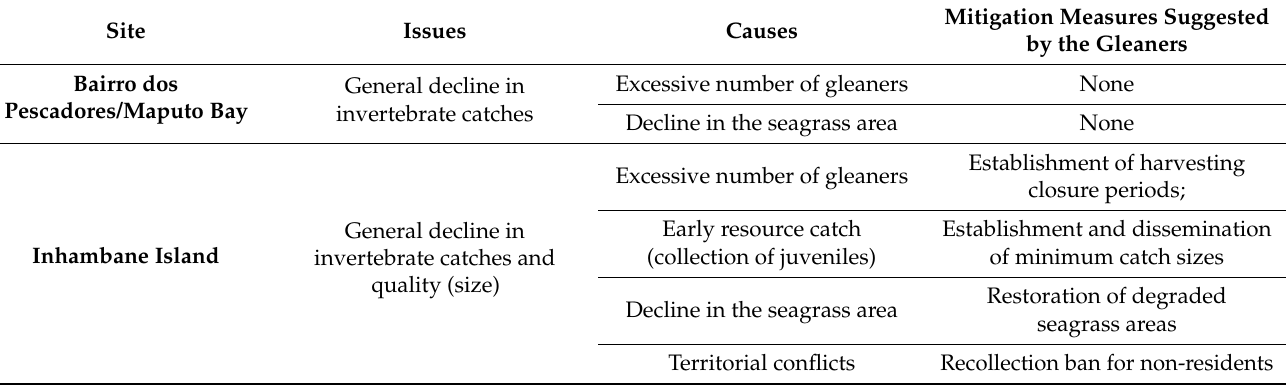
Table 7. Assessment of risk factors to gleaning sustainability on the sites, mitigation measures applied and suggested by